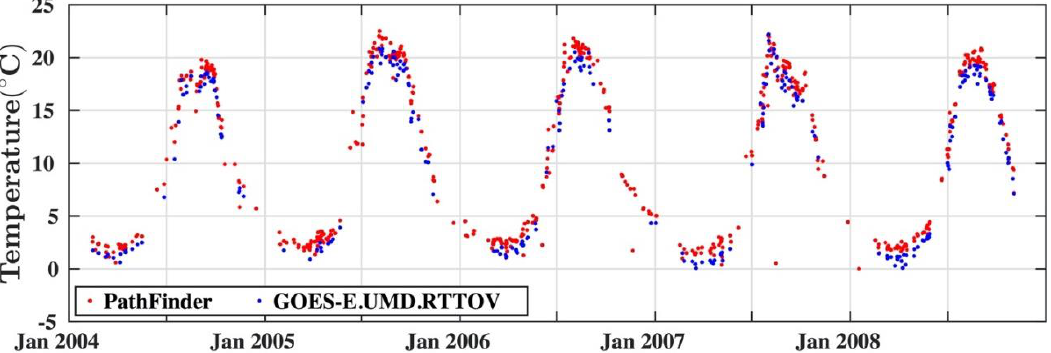
Figure 2. Instantaneous LST as derived from the JPL archive for PathFinder and from GOES-E UMD. Red dot : PathFinder data; Blue dot: GOES-E UMD. Period covered is 2004–2008. Table 1. Statistics for Figure 3 comparing the differences between GOES-E and all the other JPL